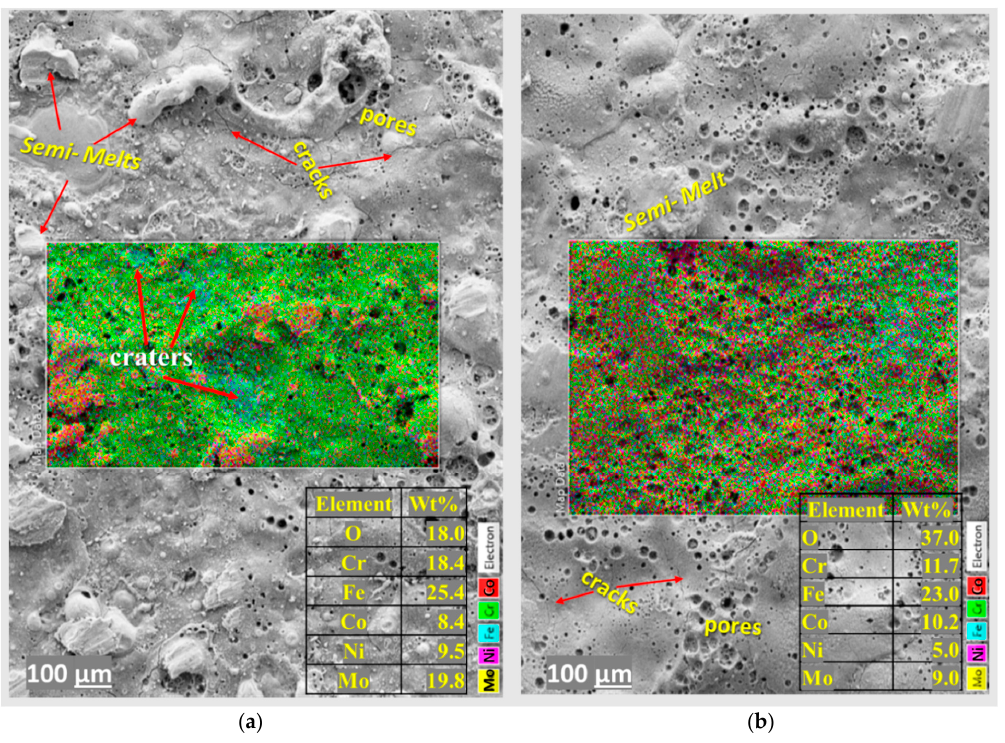
Figure 3. Top surface morphologies, elemental concentration and surface maps of the as-sprayed ( a ) ESD-HEA_Mo 27 , ( b ) ESD-HEA_Mo 20 coatings.